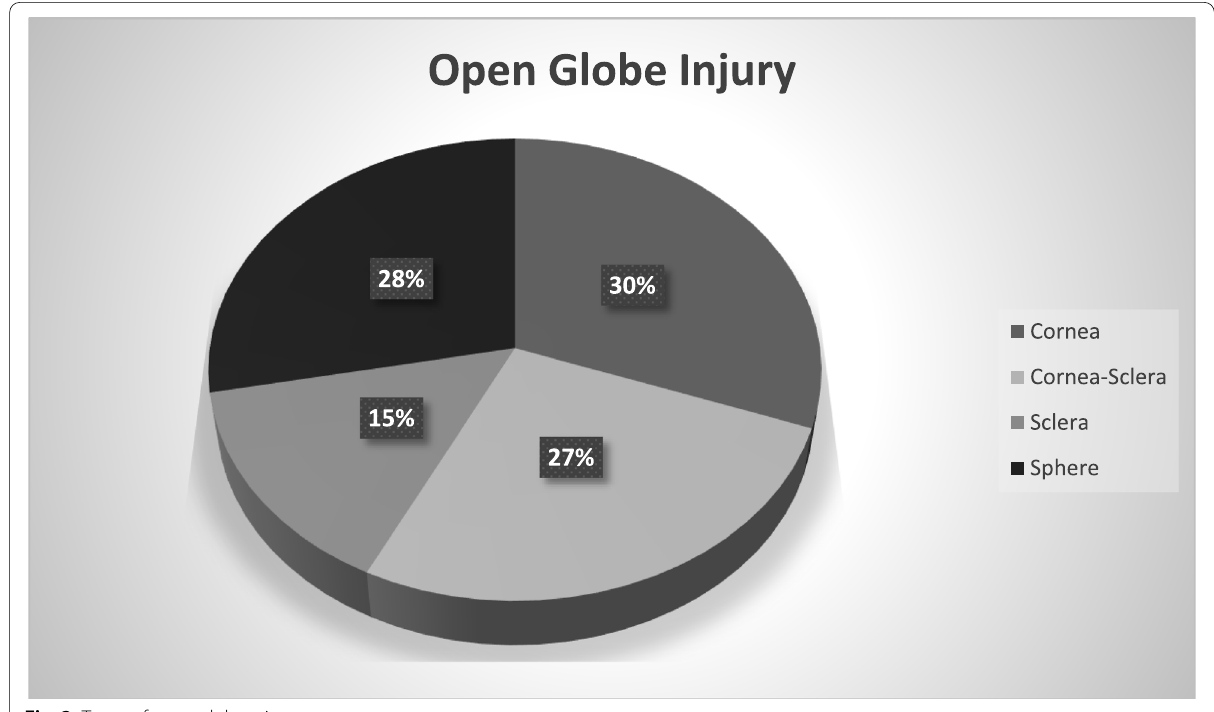
Fig. 2 Types of open globe ınjury